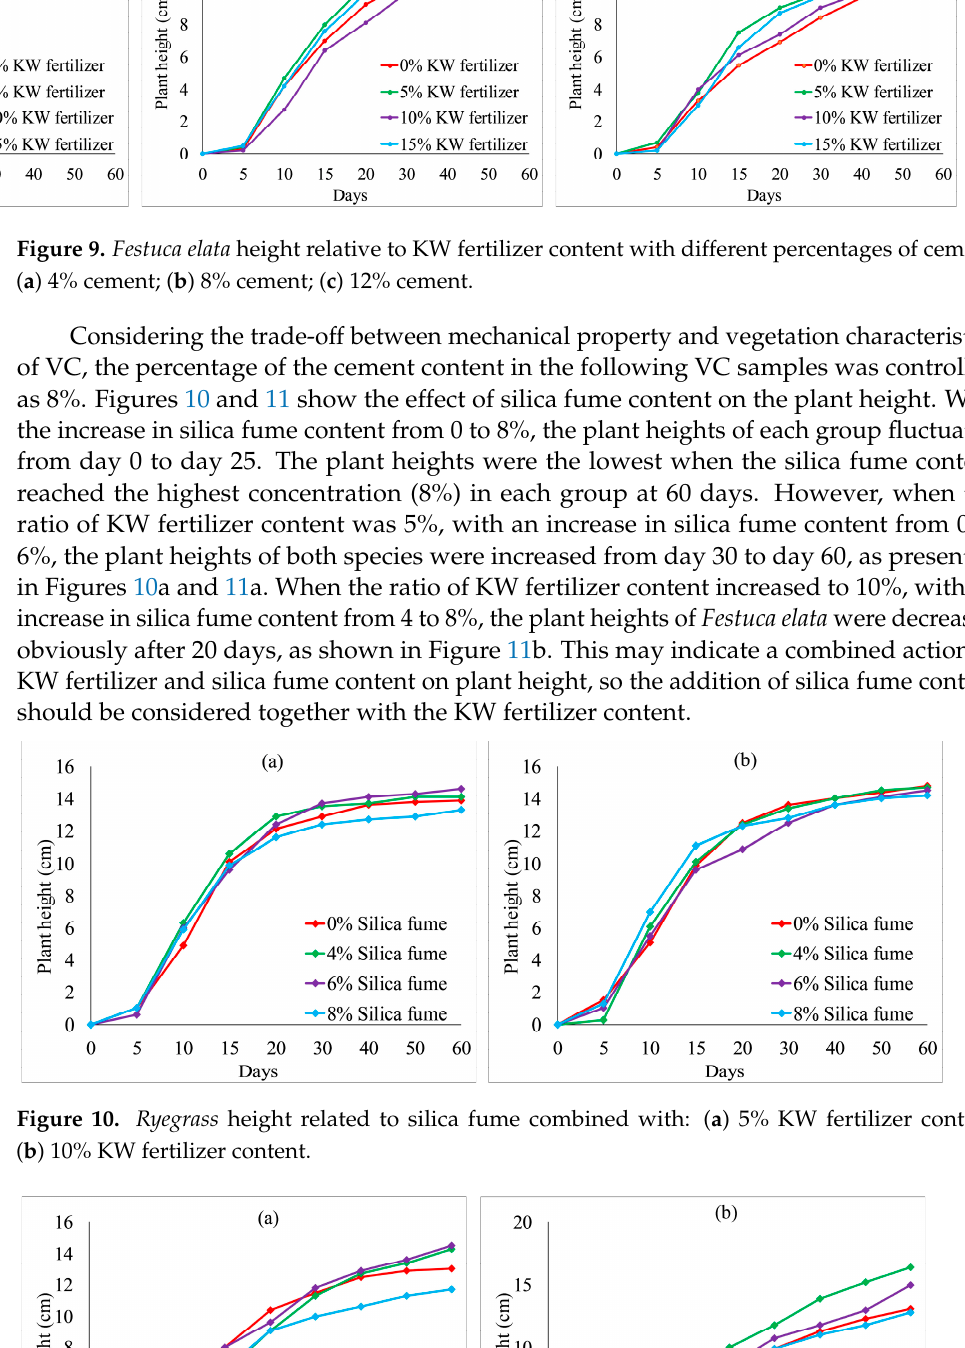
Figure 8. Ryegrass height relative to KW fertilizer content with different percentages of cement : ( a ) 4% cement; ( b ) 8% cement; ( c ) 12% cement.